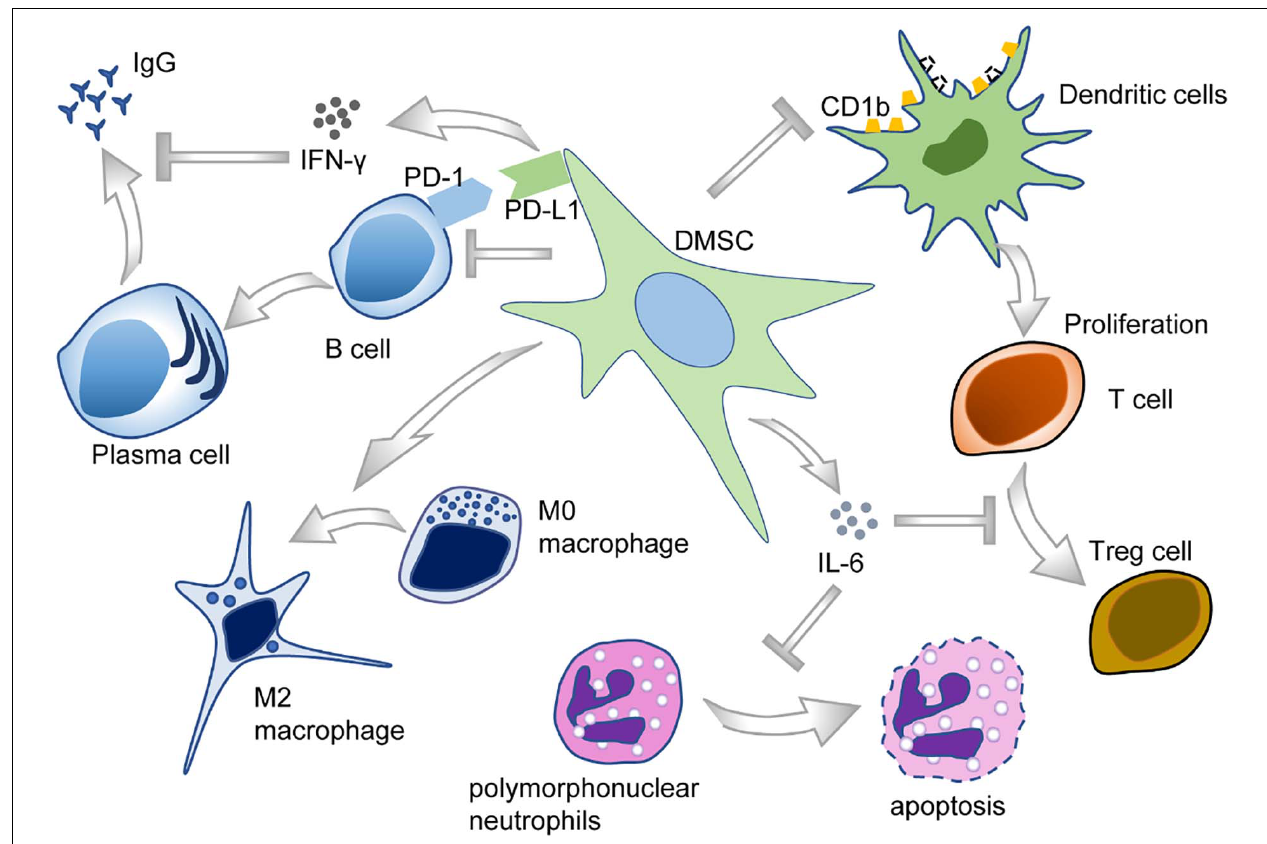
FIGURE 5 | The immunomodulatory functions of